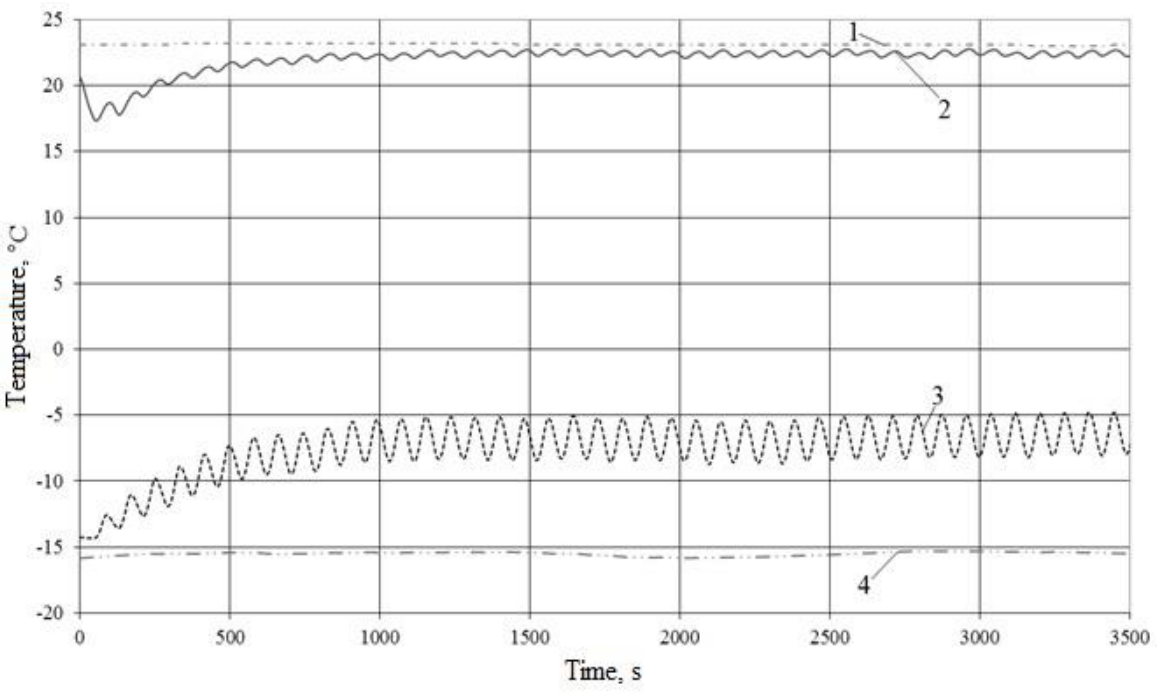
Figure 7. Experiment results example with short intervals (τ ≈ 1 h): 1: T in ; 2: T a1 ; 3: T a2 ; 4: T out.